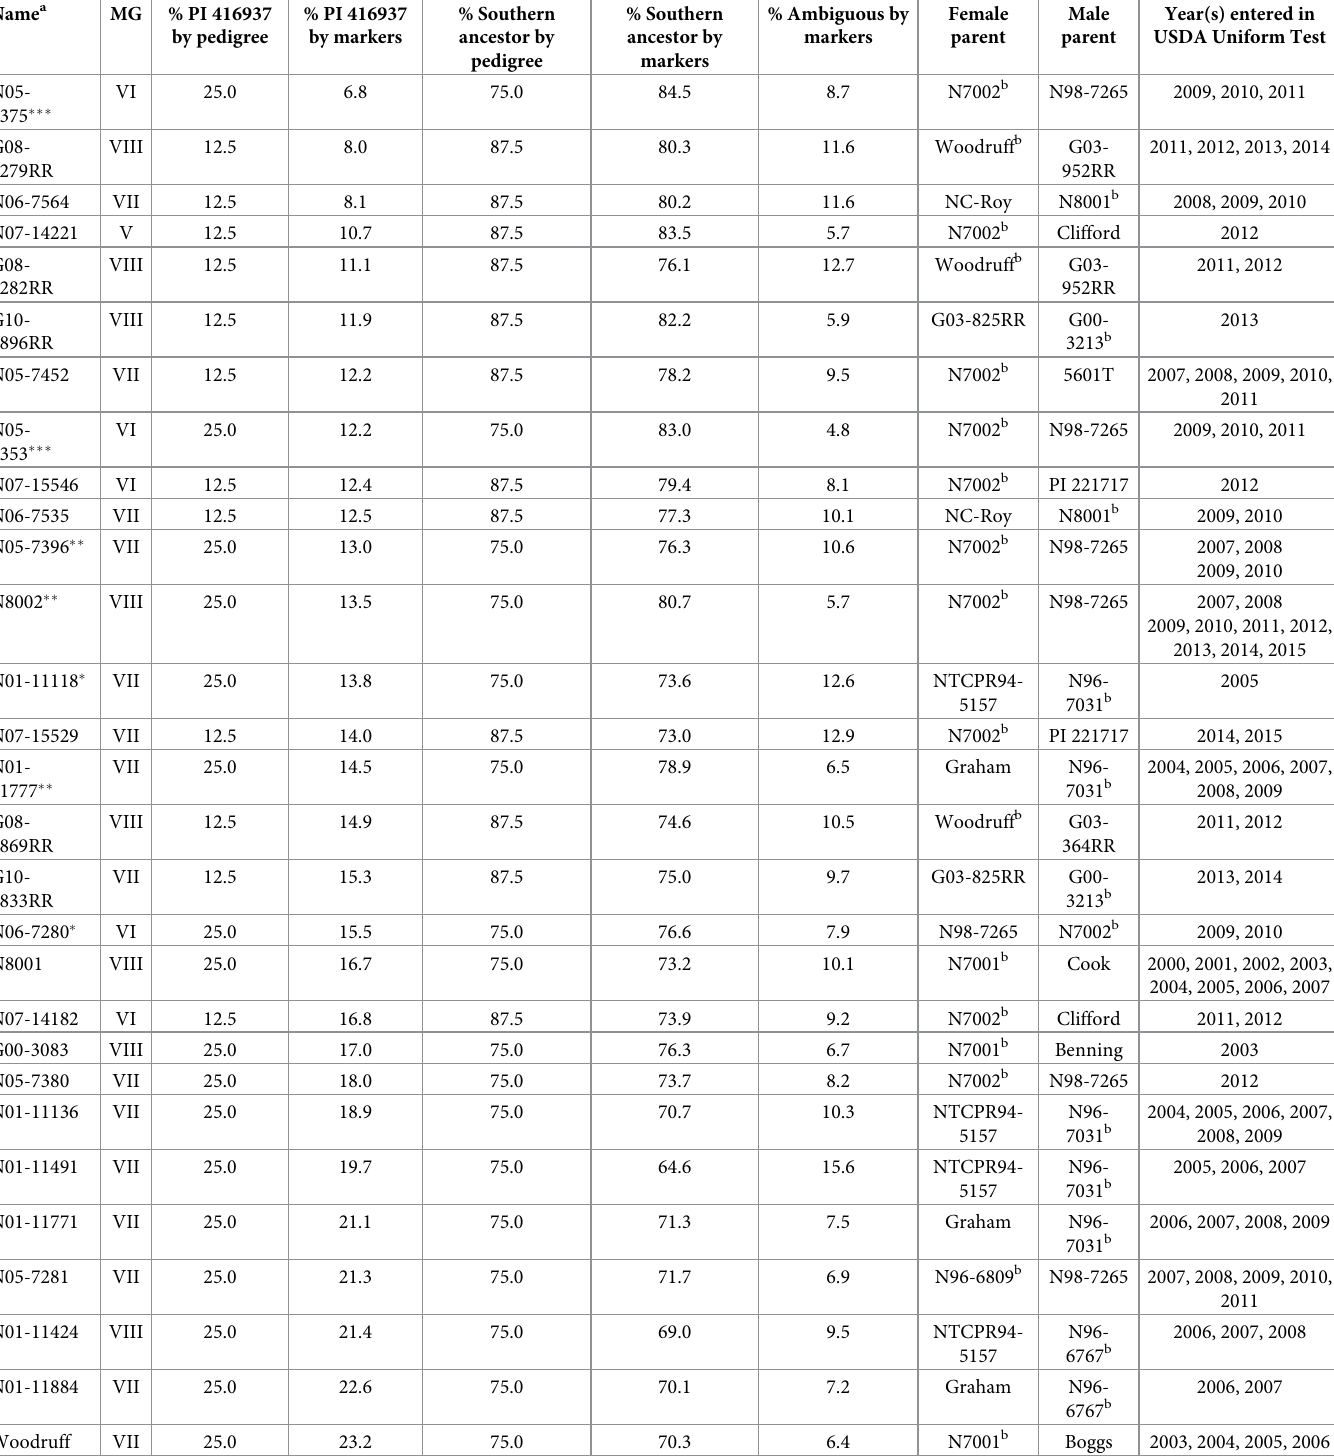
Table 1. Trios used in PI 416937 pedigree analysis and chi-square test to examine deviation of expected versus observed genomic contribution of PI 416937 and southern ancestors in each high yielding PI 416937-derived line. Ordered by % PI 416937 by